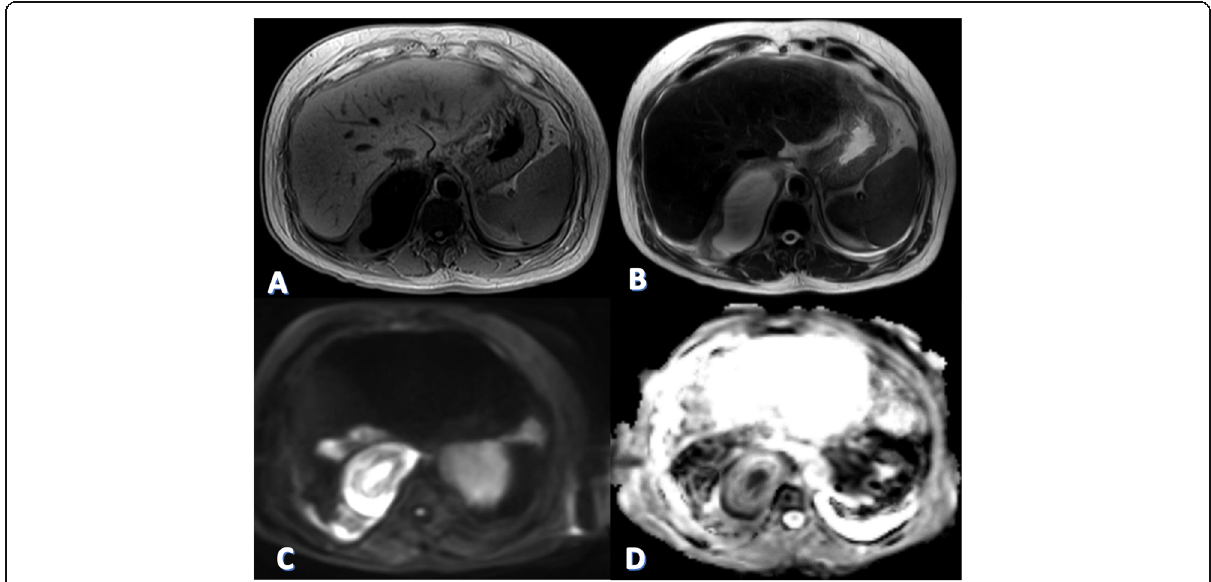
Fig. 3 a Axial T1 WI and b axial T2 WI showing a well-defined thick-walled multi-locular cystic lesion displaying low T1 and high T2 signal intensities. c DWI and d ADC map showing restricted diffusion, with the predominant bright areas on DWI corresponding to dark areas on the ADC map (ADC mean = 0.82 × 10 − 3 mm 2 /s). Ultrasound-guided aspiration cytology revealed pus cells